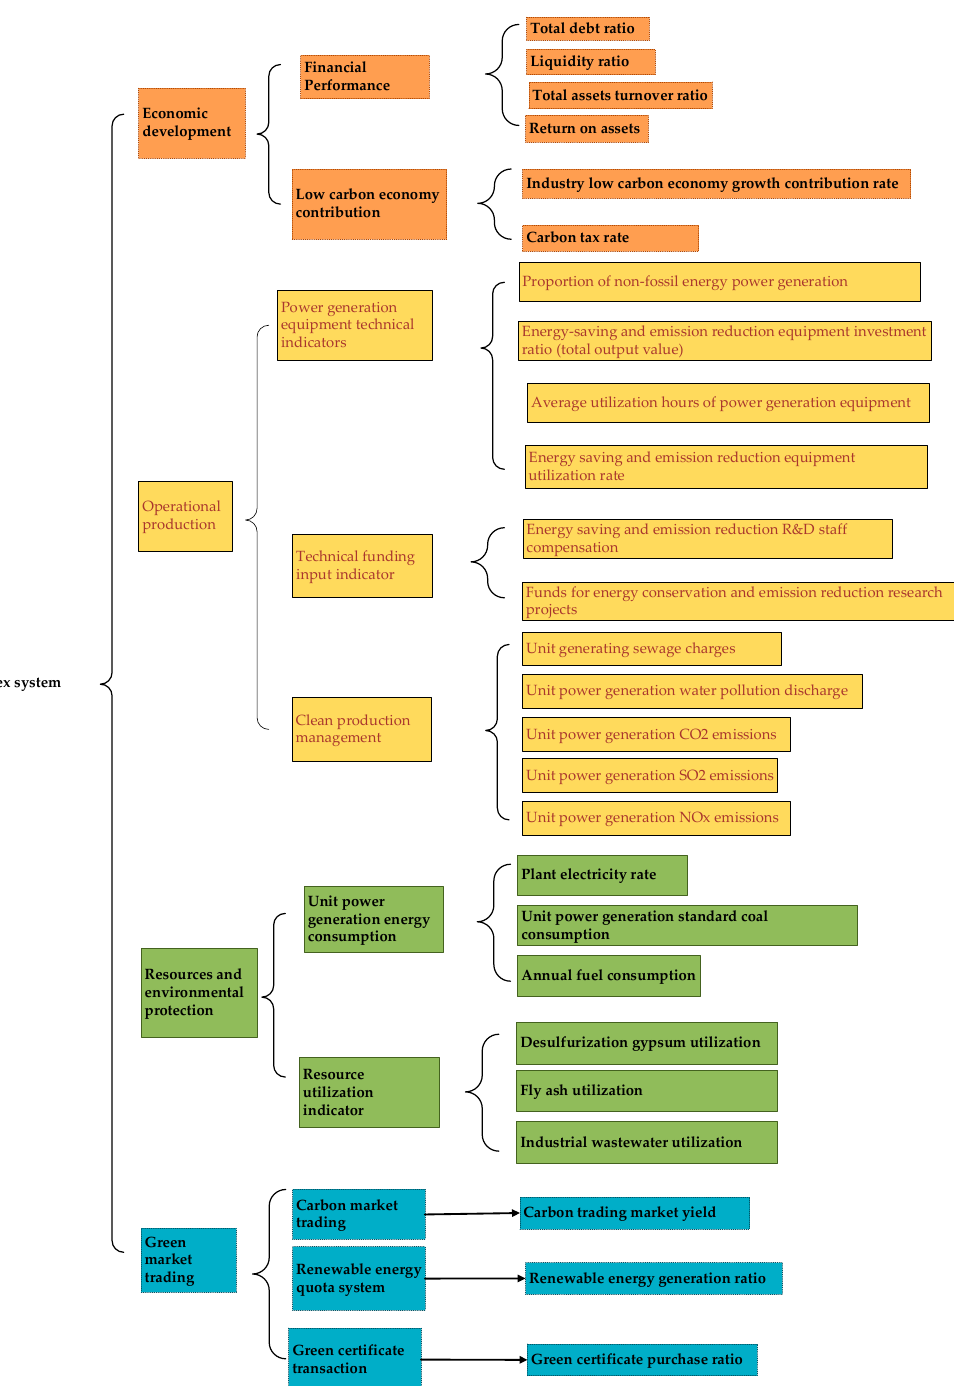
Figure 1. Low-carbon sustainability and green operation benefits evaluation index system of power generation enterprises.